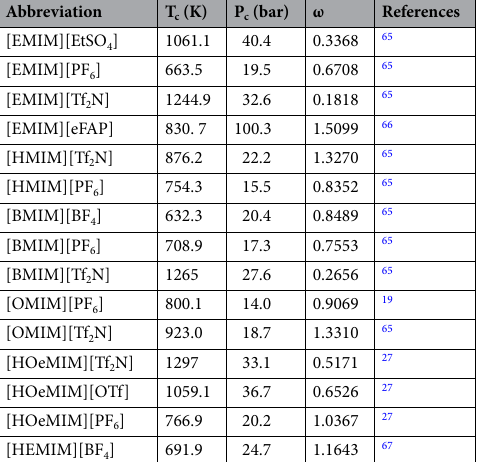
Table 2. The critical temperature, pressure, and acentric factors of ILs used in this